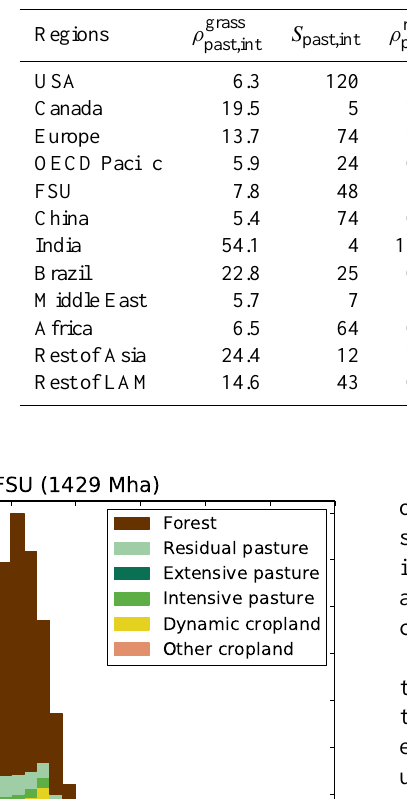
S past,ext in Mha and, production of extensive ruminant meat and milk per hectare of extensive permanent pasture ρ r,ext past in Mkcalha − 1 yr − 1 . Yield of pastures are the quantity of grass grazed on a unit of land and not the total grass grown.